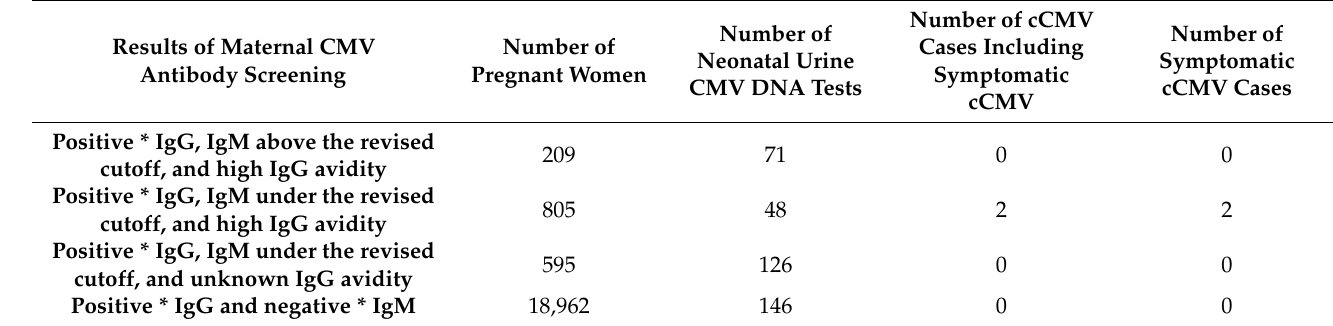
Table 2. Numbers of pregnant women, neonatal urine cytomegalovirus (CMV) DNA tests, and con- genital cytomegalovirus (cCMV) cases according to the results of maternal CMV antibody